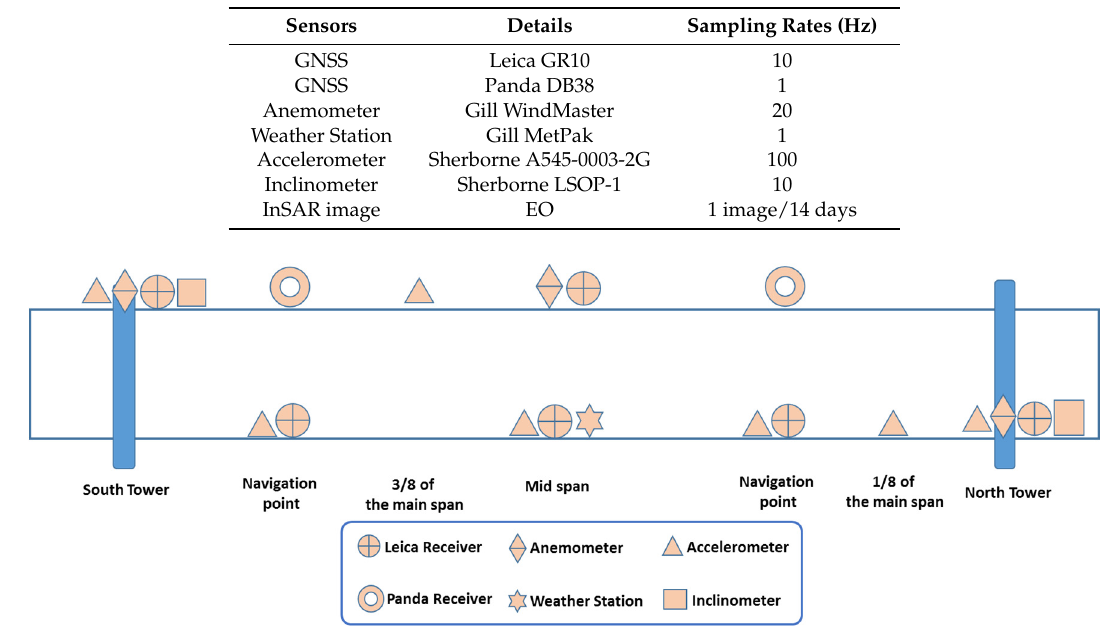
Table 1. Details of sensors to be installed during the GeoSHM Demo Project.